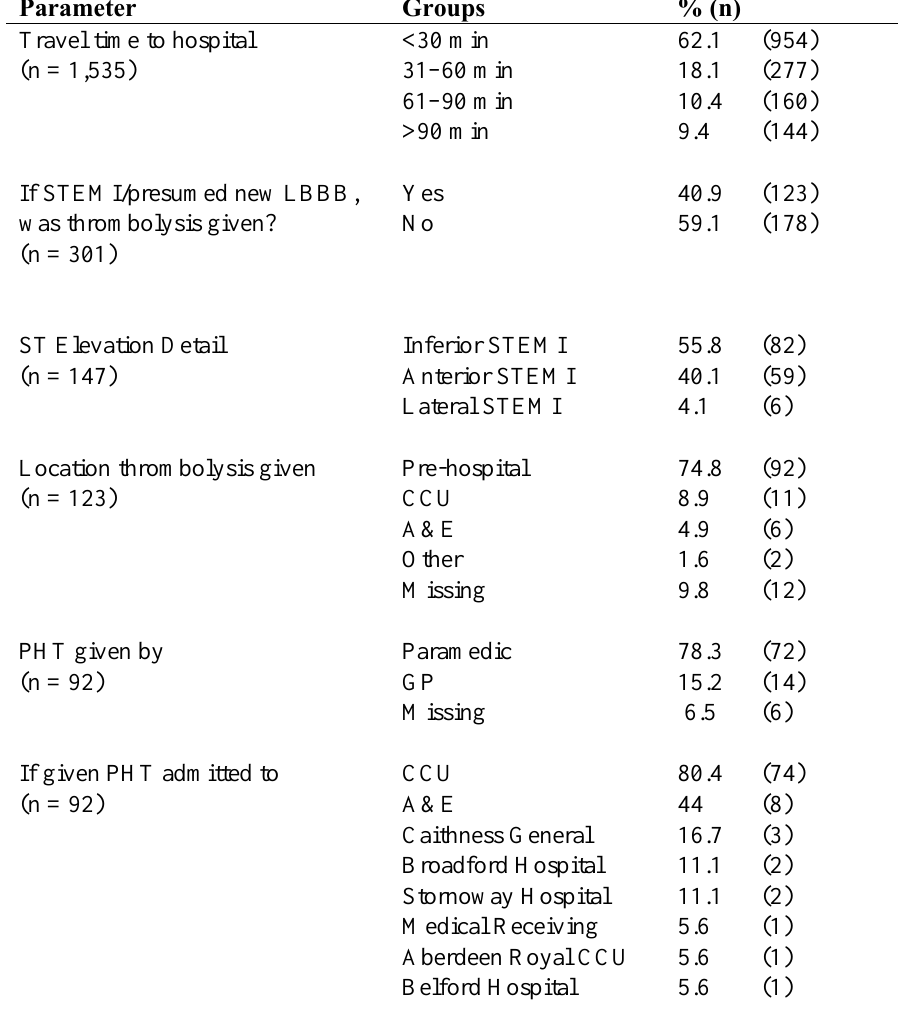
Table 2. ECG e-transmission and subsequent